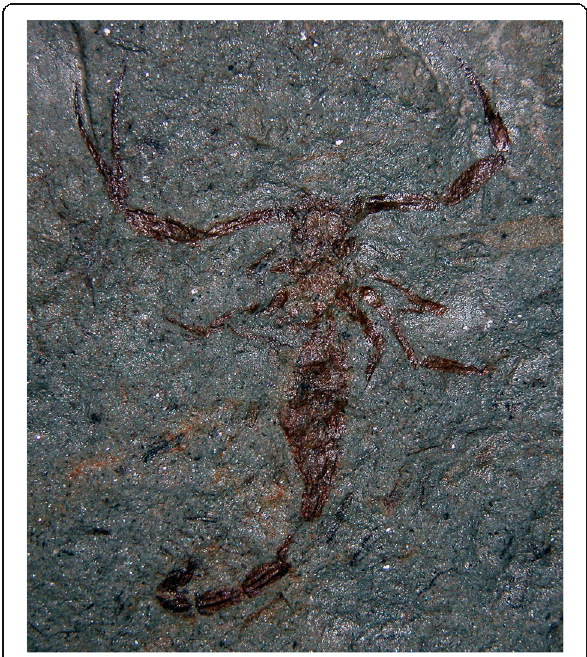
Fig. 1 Protobuthus elegans Lourenço & Gall. Fossil scorpion from Early Triassic, France. The specimen, an adult male, clearly presents a telson